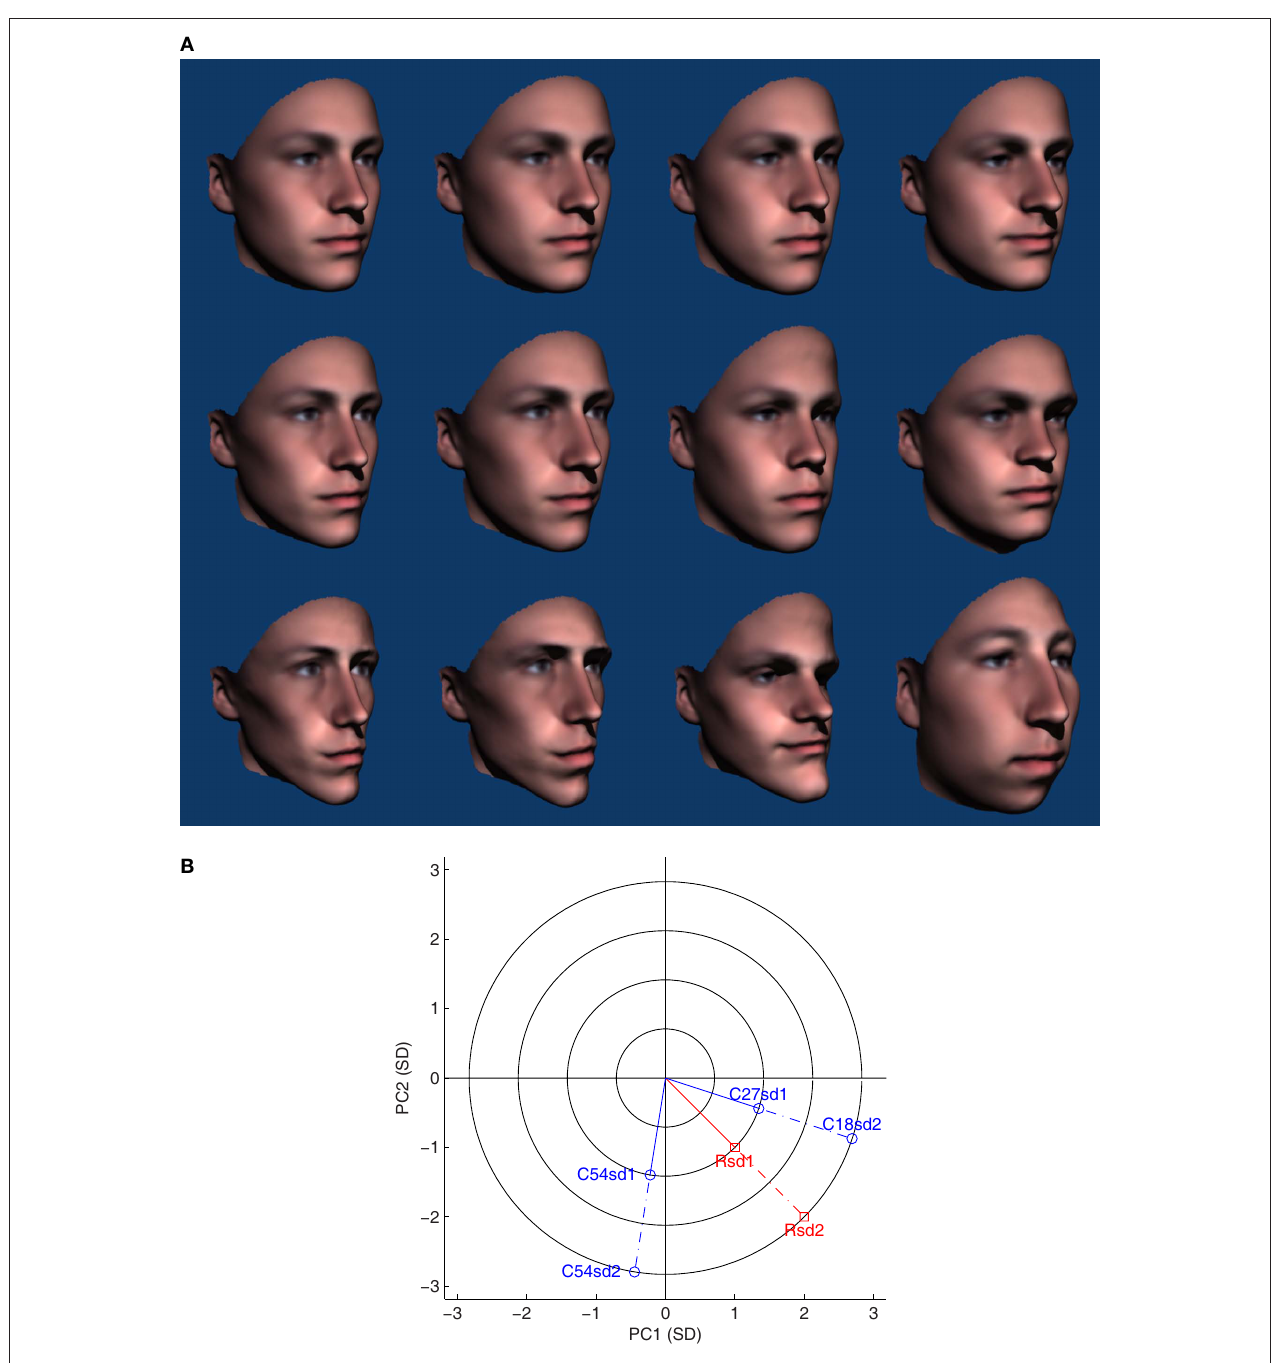
reference and comparison faces in Experiment 3. Concentric circles show the four levels of distinctiveness used, 0.5, 1, 1.5, and 2 SD. Reference faces for the 1 and 2 SD conditions are indicated in red as R1SD and R2SD respectively. Corresponding comparison faces are shown in blue. C1SD27 and C1SD54 are possible 27 ° and 54 ° comparison faces for the R1SD reference face. C2SD27 and C2SD54 are the equivalent comparison faces for the R2SD reference face. The angle subtended at the origin remains constant between conditions but the distance between equivalent reference and comparison faces is greater for the 2